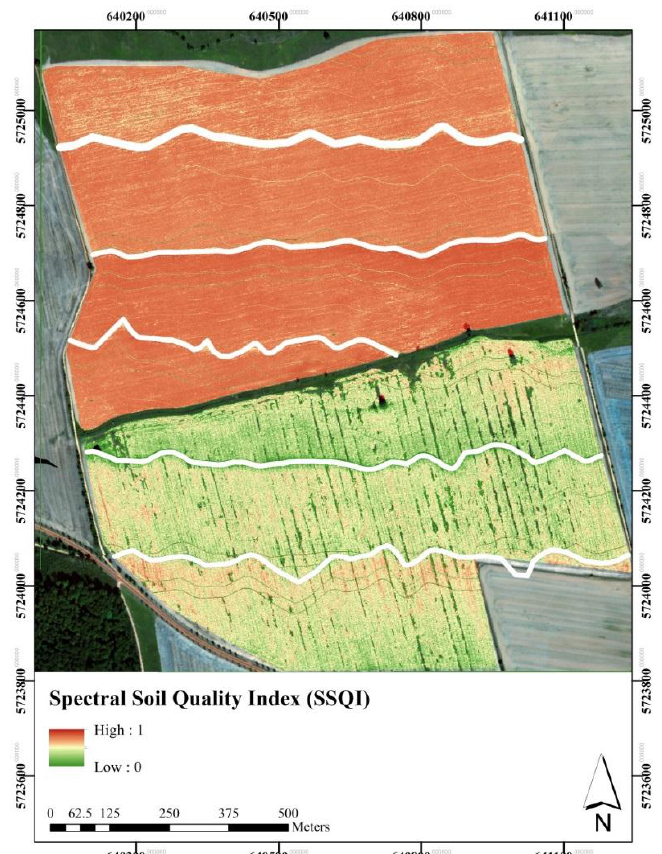
Figure 12. Hyperspectral imaging spectroscopy of the spectral soil quality index (SSQI) at Schäfertal site,